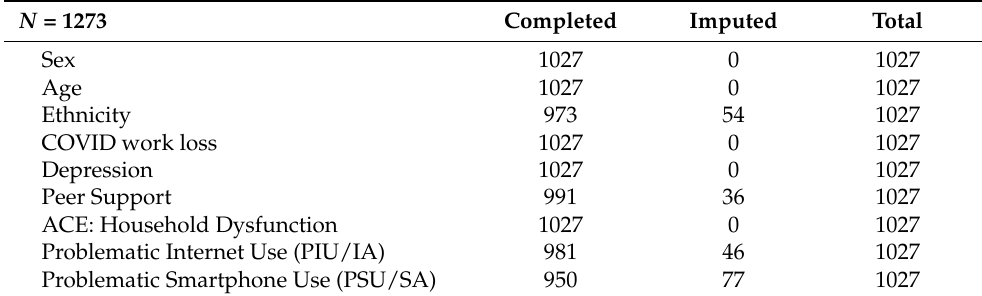
Table 1. Summary of missing